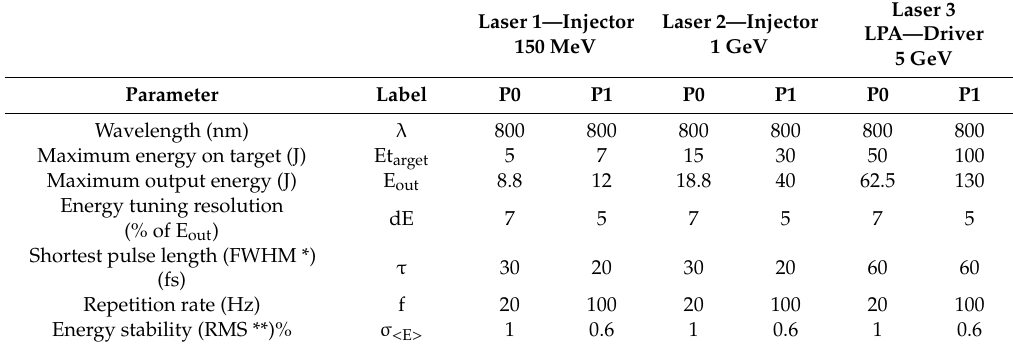
Table 1. Laser emission parameters for the three devices envisaged for laser plasma injection and acceleration, at the levels of performance of P0 and P1. The maximum output energy (before transport and compression) has been calculated from the requirements of energy on target, assuming an overall e ffi ciency of 80% of the compression and the beam transport system. For Laser 1, a further amount of energy output has been considered for the diagnostic beams (2.5 J at P0 and 3.8 J at